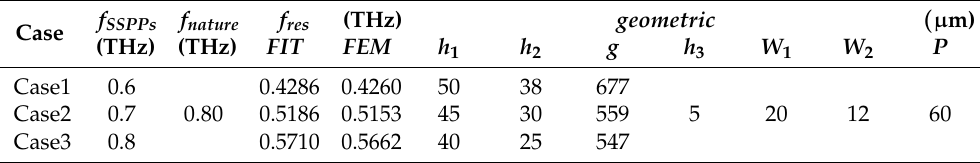
Table 5. Geometric parameters with samples